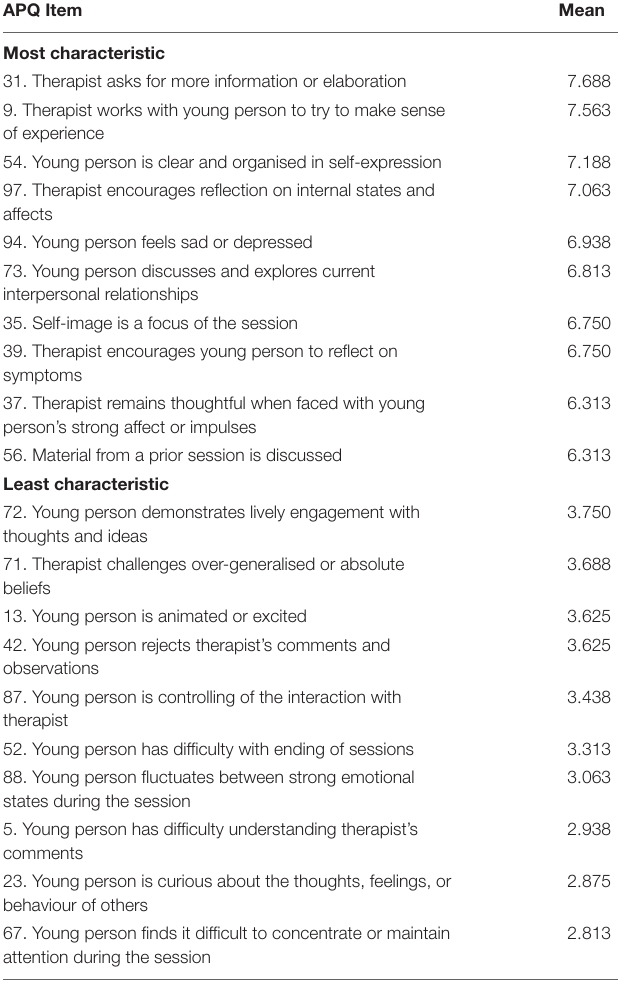
TABLE 2 | The ten most and ten least characteristic items of the treatment process of